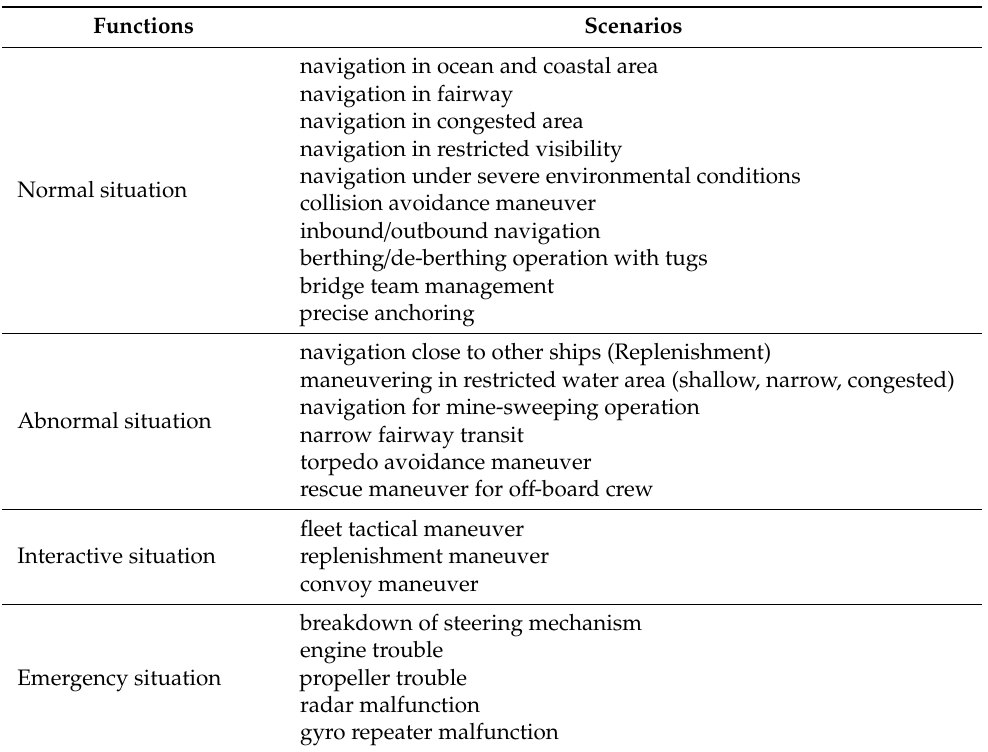
Table 4. Simulation